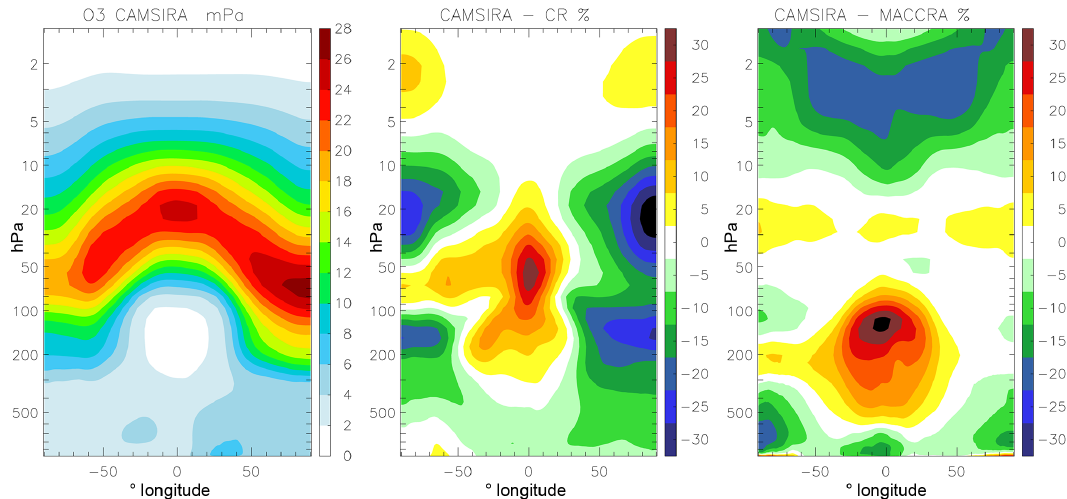
Figure 14. Zonally averaged ozone partial pressure (mPa) of CAMSiRA (2003–2015, left) and relative difference (%) compared with the CR (2003–2015, middle) and MACCRA